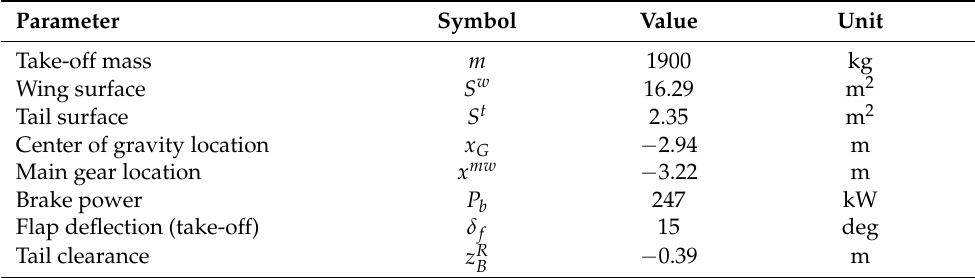
Figure 4. Diamond Aircraft DA-42 [24]. Table 1. Basic data for baseline two-surface aircraft. Geometrical positions are assigned from the forward tip of the fuselage, positive